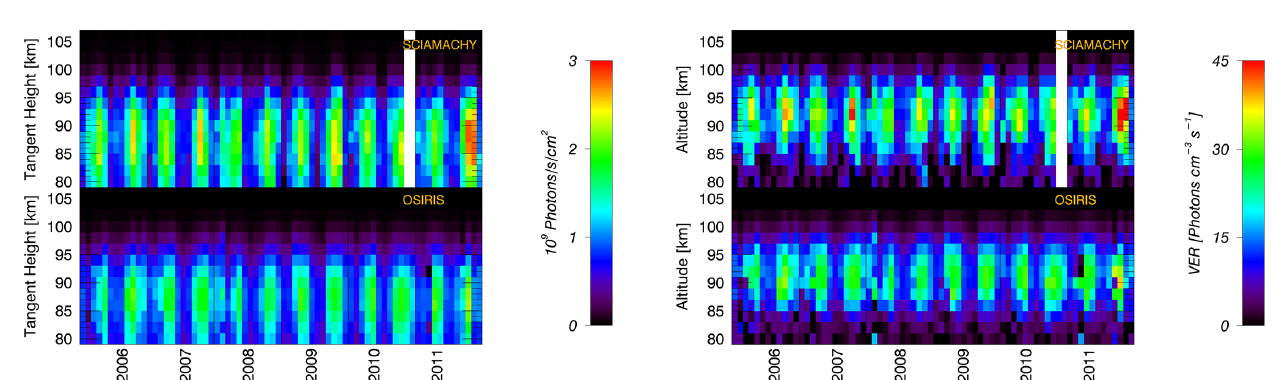
Figure 5. Time and altitude dependence of LER calculated from SCIAMACHY and OSIRIS nighttime limb measurements. We av- eraged over all measurements carried out in one month and in the − 30 to 30 ◦ latitude band. Both instruments detect a semi-annual cycle with peaks in the spring and fall months. The white regions are previously selected regions with a low SNR.